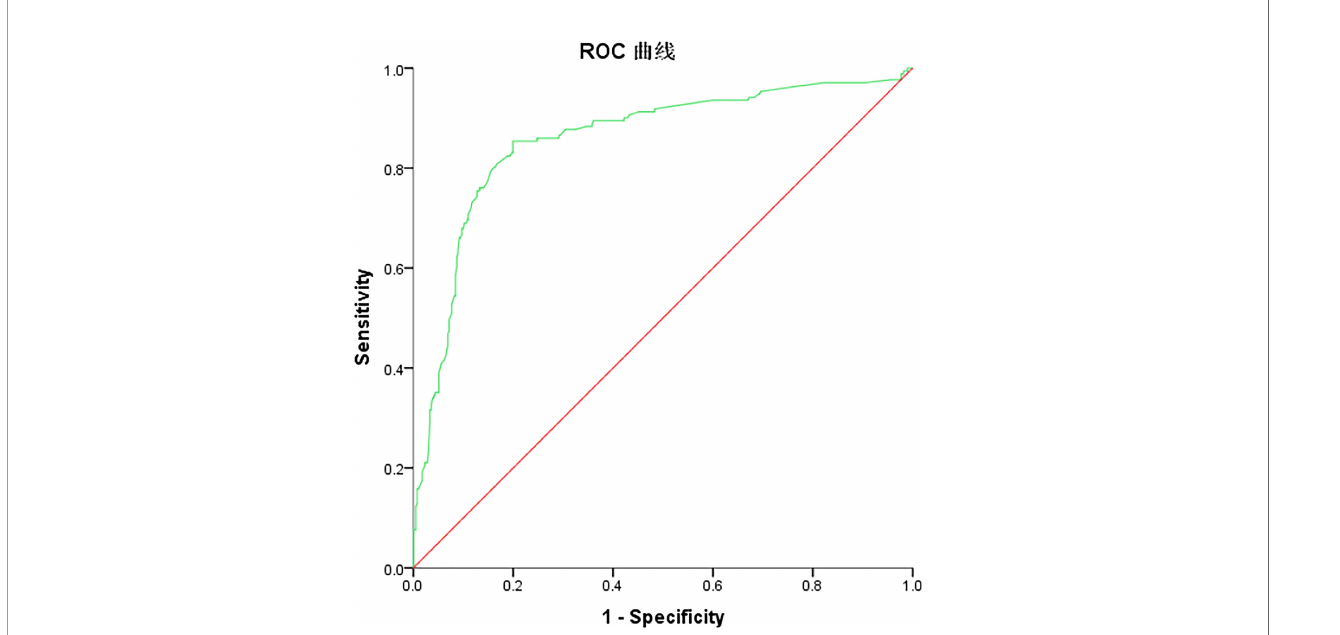
FIGURE 1 | ROC curve of the logistic regression model for predicting LN-prRLN metastasis.